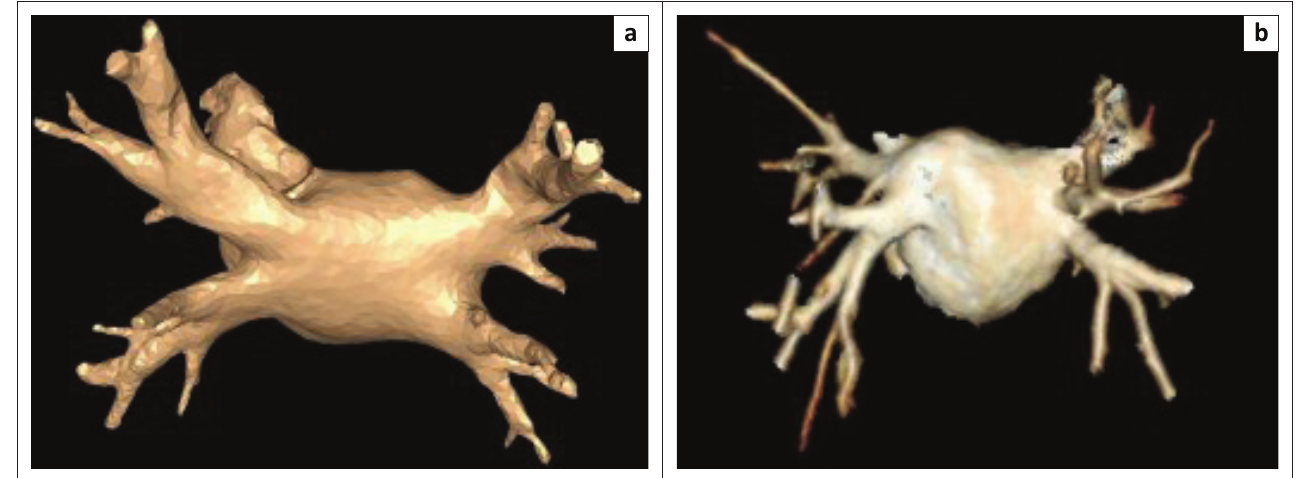
FIGURE 1: 3D reconstructed data from: (a) CTA and (b) MRA both show exquisite detail in the structure of the left atrium and pulmonary veins.